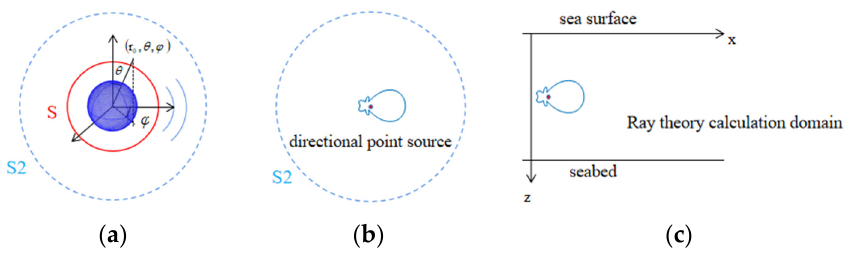
Figure 1. Schematic of equivalent theory of directional point source. ( a ) Part of FEM and spherical wave expansion; ( b ) Part of directional point source equivalence; and, ( c ) Part of ray theory.